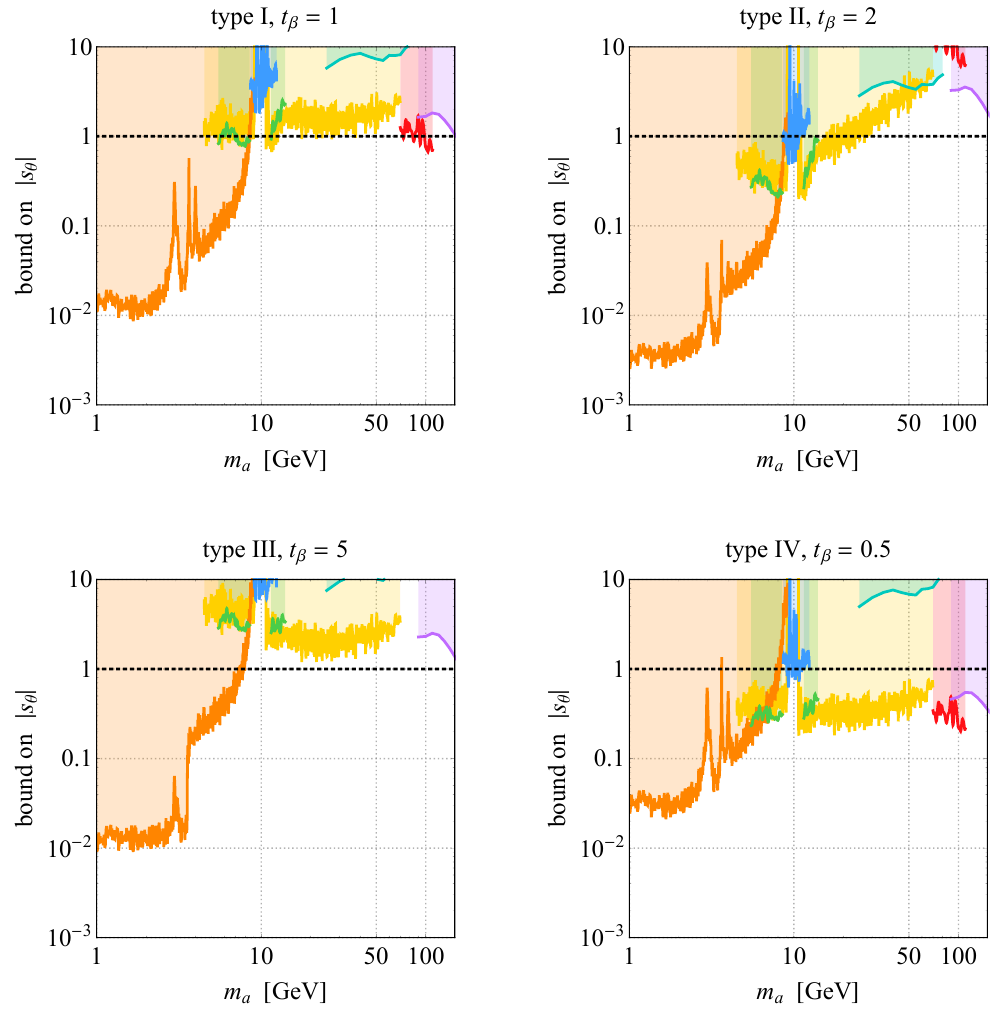
Figure 3 . Limits on j s (cid:18) j in the 2HDM+S of type I with t (cid:12) = 1 (top left), type II with t (cid:12) = 2 (top right), type III with t (cid:12) = 5 (bottom left) and type IV with t (cid:12) = 0 : 5 (bottom right). The green, turquoise, red, purple, orange, blue and yellow exclusions correspond to the searches for a ! (cid:22) + (cid:22) (cid:0) [25], pp ! ab (cid:22) b ! (cid:28) + (cid:28) (cid:0) b (cid:22) b [26], pp ! a ! (cid:13)(cid:13) [28], pp ! a ! (cid:28) + (cid:28) (cid:0) [30] and (cid:7)(1 S ) ! a(cid:13) ! (cid:22) + (cid:22) (cid:0) (cid:13) [32], the measurements of (cid:7) production [15, 34] and the inclusive dimuon cross section [36], respectively. The dashed black lines indicate j s (cid:18) j = 1 and all coloured regions are excluded at 95% CL apart from the orange and yellow contours which only hold at 90%